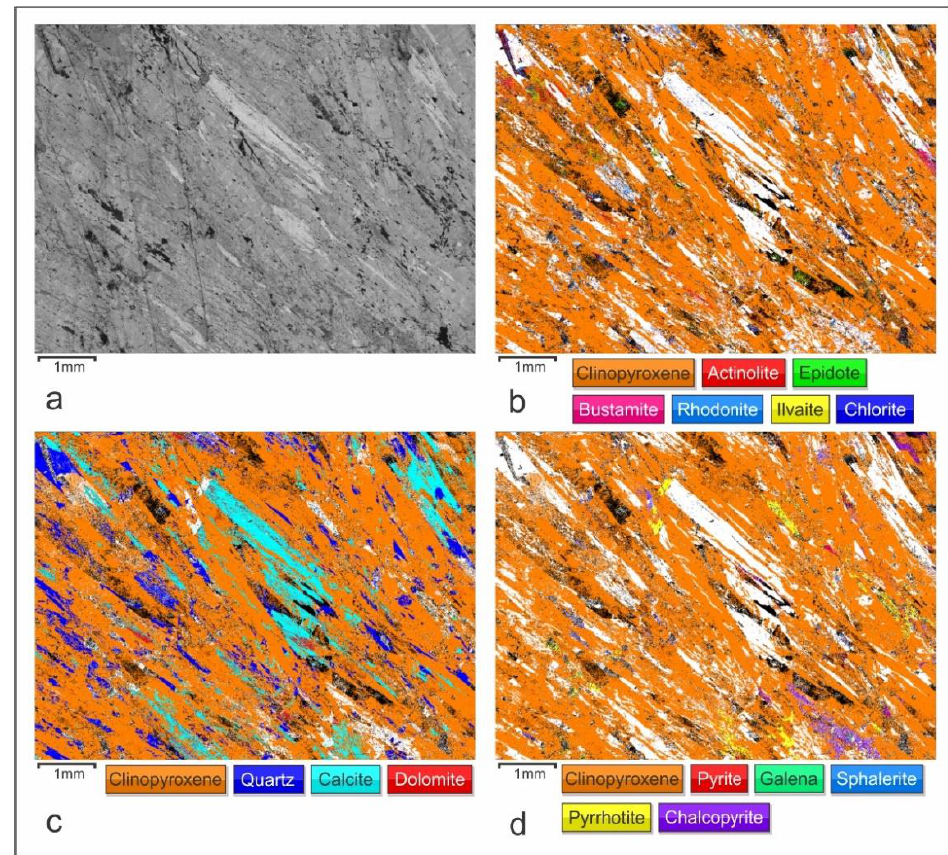
Figure 9. The EBSD maps illustrating the retrograde alterations of prograde pyroxene under an increased CO 2 fugacity: ( a ) Band contrast EBSD map; ( b ) Distribution of prograde clinopyroxene and retrograde hydrous silicates; ( c ) Distribution of prograde clinopyroxene and retrograde/hydrothermal carbonates and quartz; ( d ) Distribution of prograde clinopyroxene and hydrothermal sulfide mineralization. The EBSD mapping step size was 6 µm and the indexing rate was 88.4%.